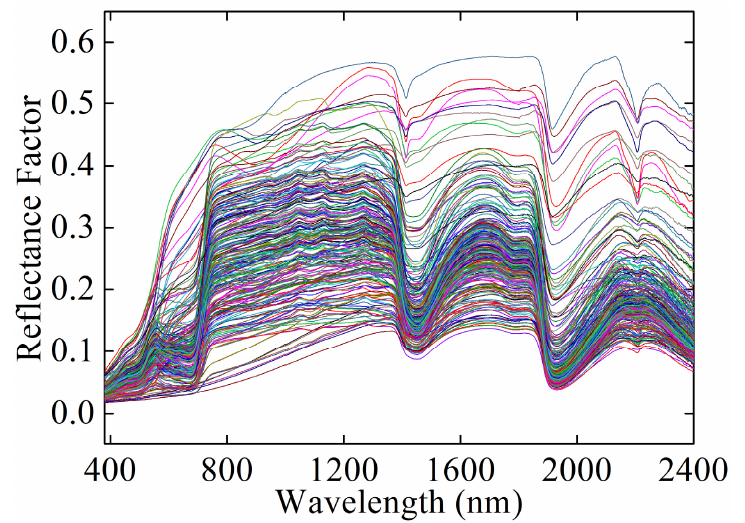
Figure 3. The part of original